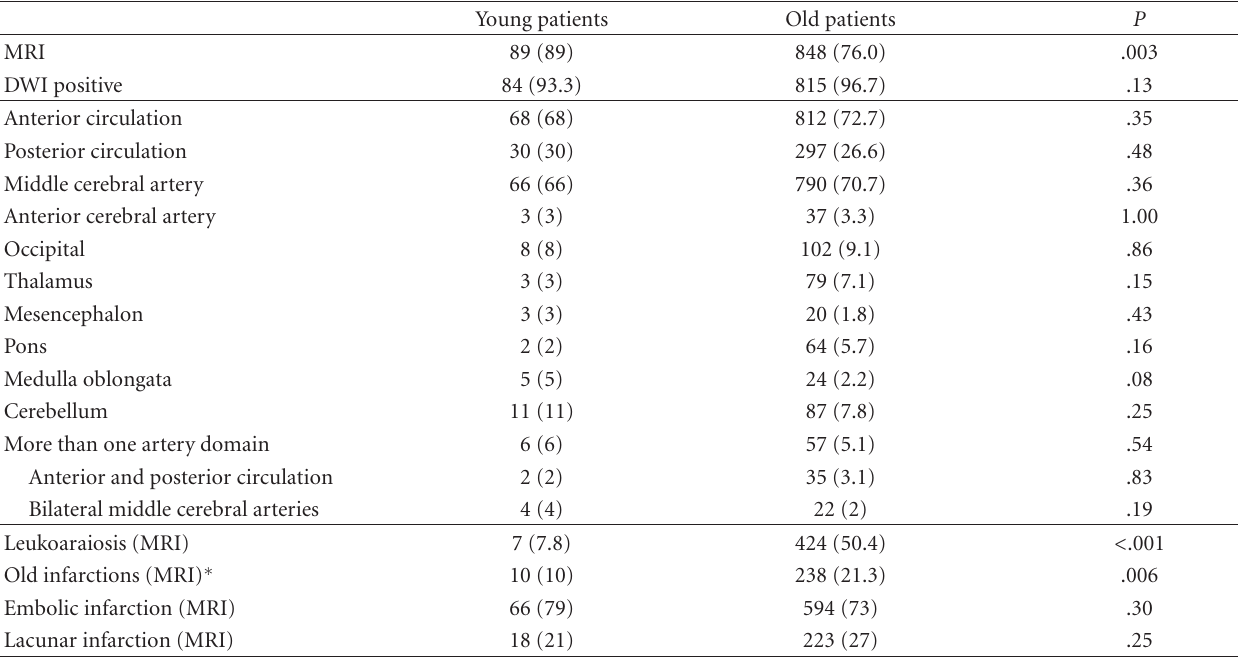
Table 6: MRI findings among young and old patients with cerebral